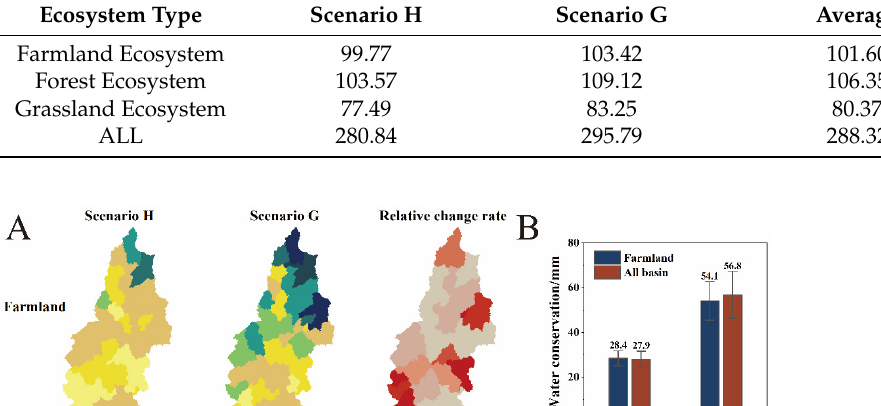
Figure 3. The spatial and temporal distribution of the WCA (mm) in each ecosystem during the wet season ( A ) versus relative changes ( B ).